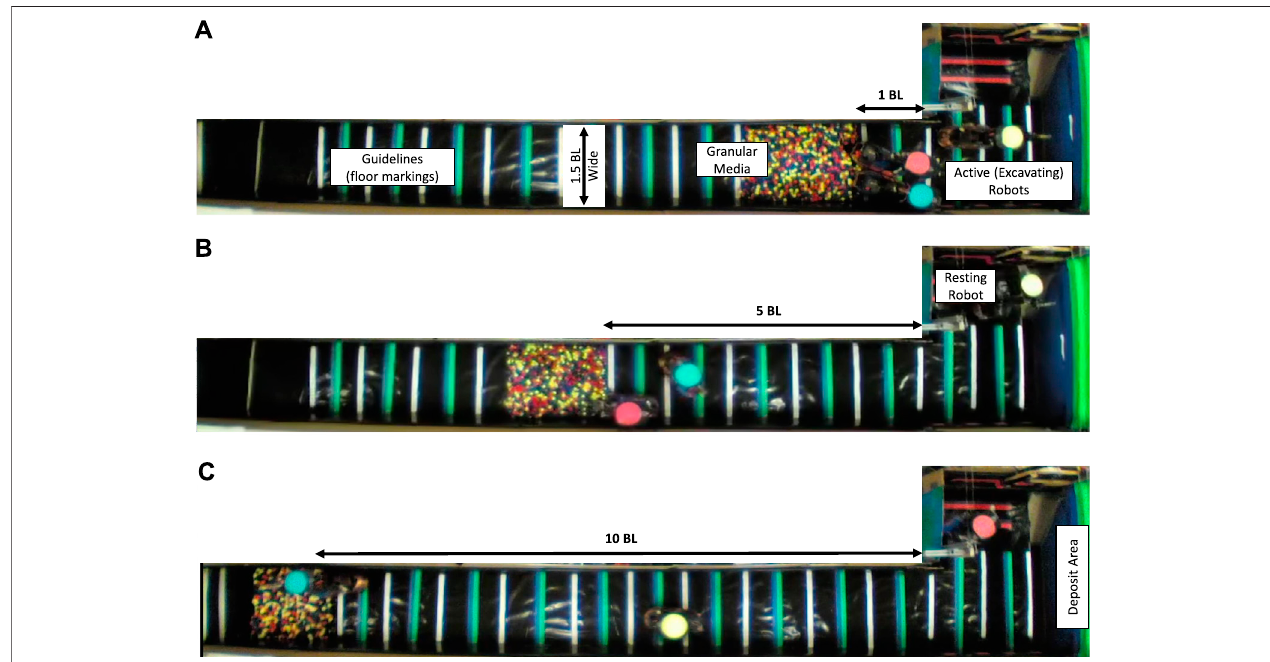
FIGURE 4 | Three snapshots of the top view of multi-robot excavation experiments. (A) Pellets at one body-length (1BL) of the tunnel which is the initial position of the pellets at the beginning of each trial, (B) pellets at fi ve body-length (5BL) of the tunnel after robots have excavated 1200 g of pellets, (C) pellets at ten body-length (10BL) of the tunnel after robots have excavated 2700 g of pellets.